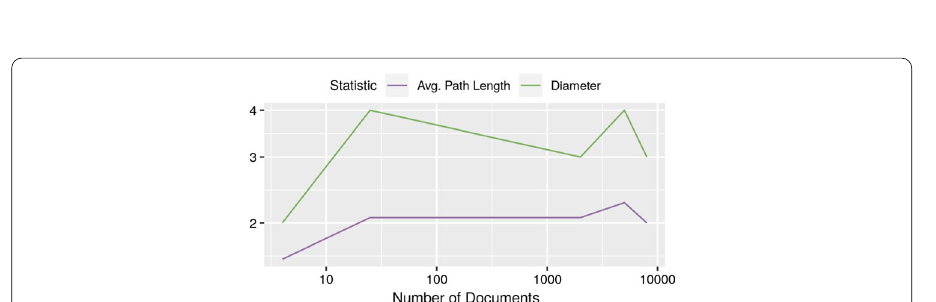
Fig. 20 Average estimated diameter and average shortest path over time for the context